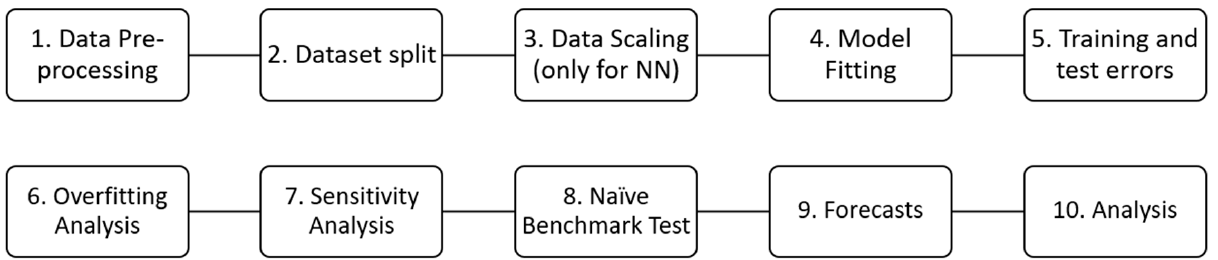
Figure 1. Diagram of the ten-step machine learning approach for generating forecasts.